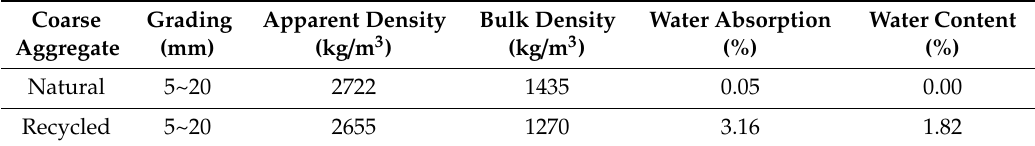
Table 2. The physical properties of the coarse aggregate.